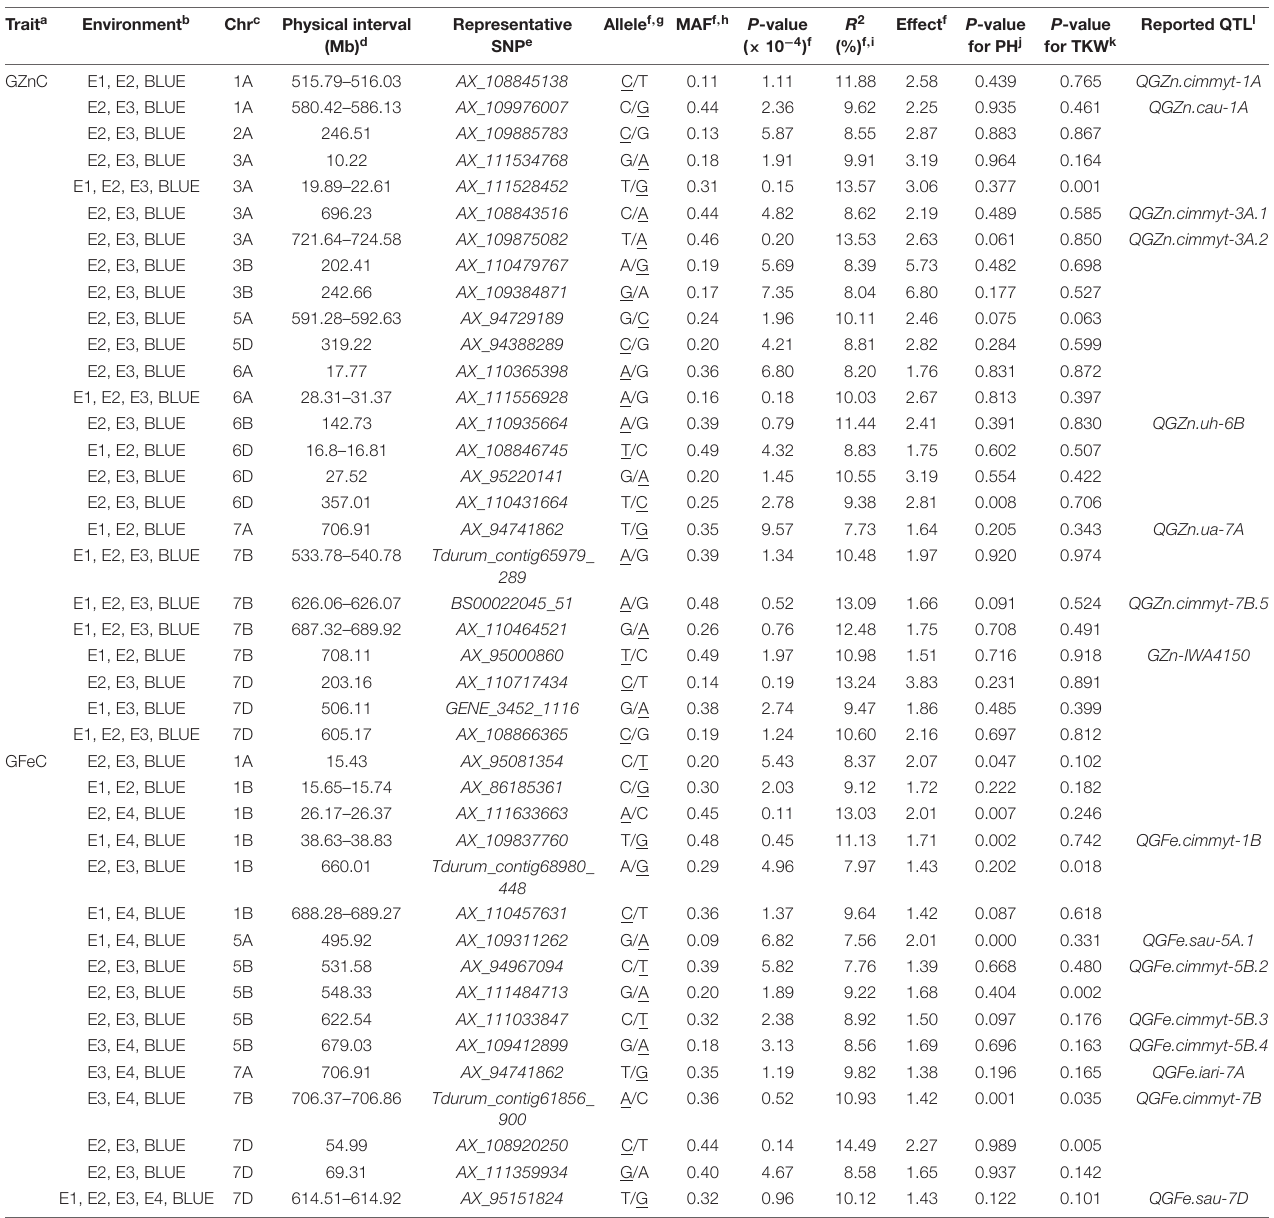
TABLE 2 | Significant loci associated with GZnC and GFeC in at least three environments in 166 wheat accessions using three models in GAPIT. Trait a Environment